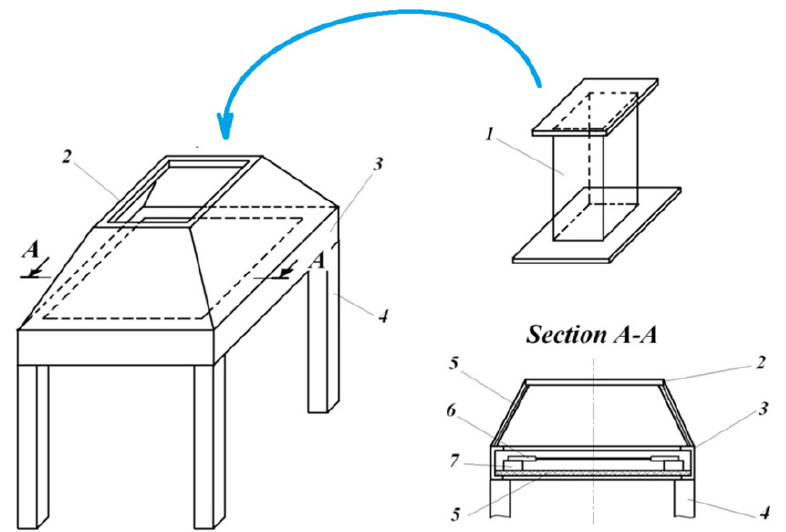
Figure 1. The original testing bench [1,56,64]: 1-tested structural element; 2-dome in form of pyramid trunk; 3-rigid frame; 4-supporting legs; 5-heat insulation layer; 6-heating elements (Silite rods); 7 -chamotte bricks. The blue arrow shows how the tested element has to be placed on/over the dome